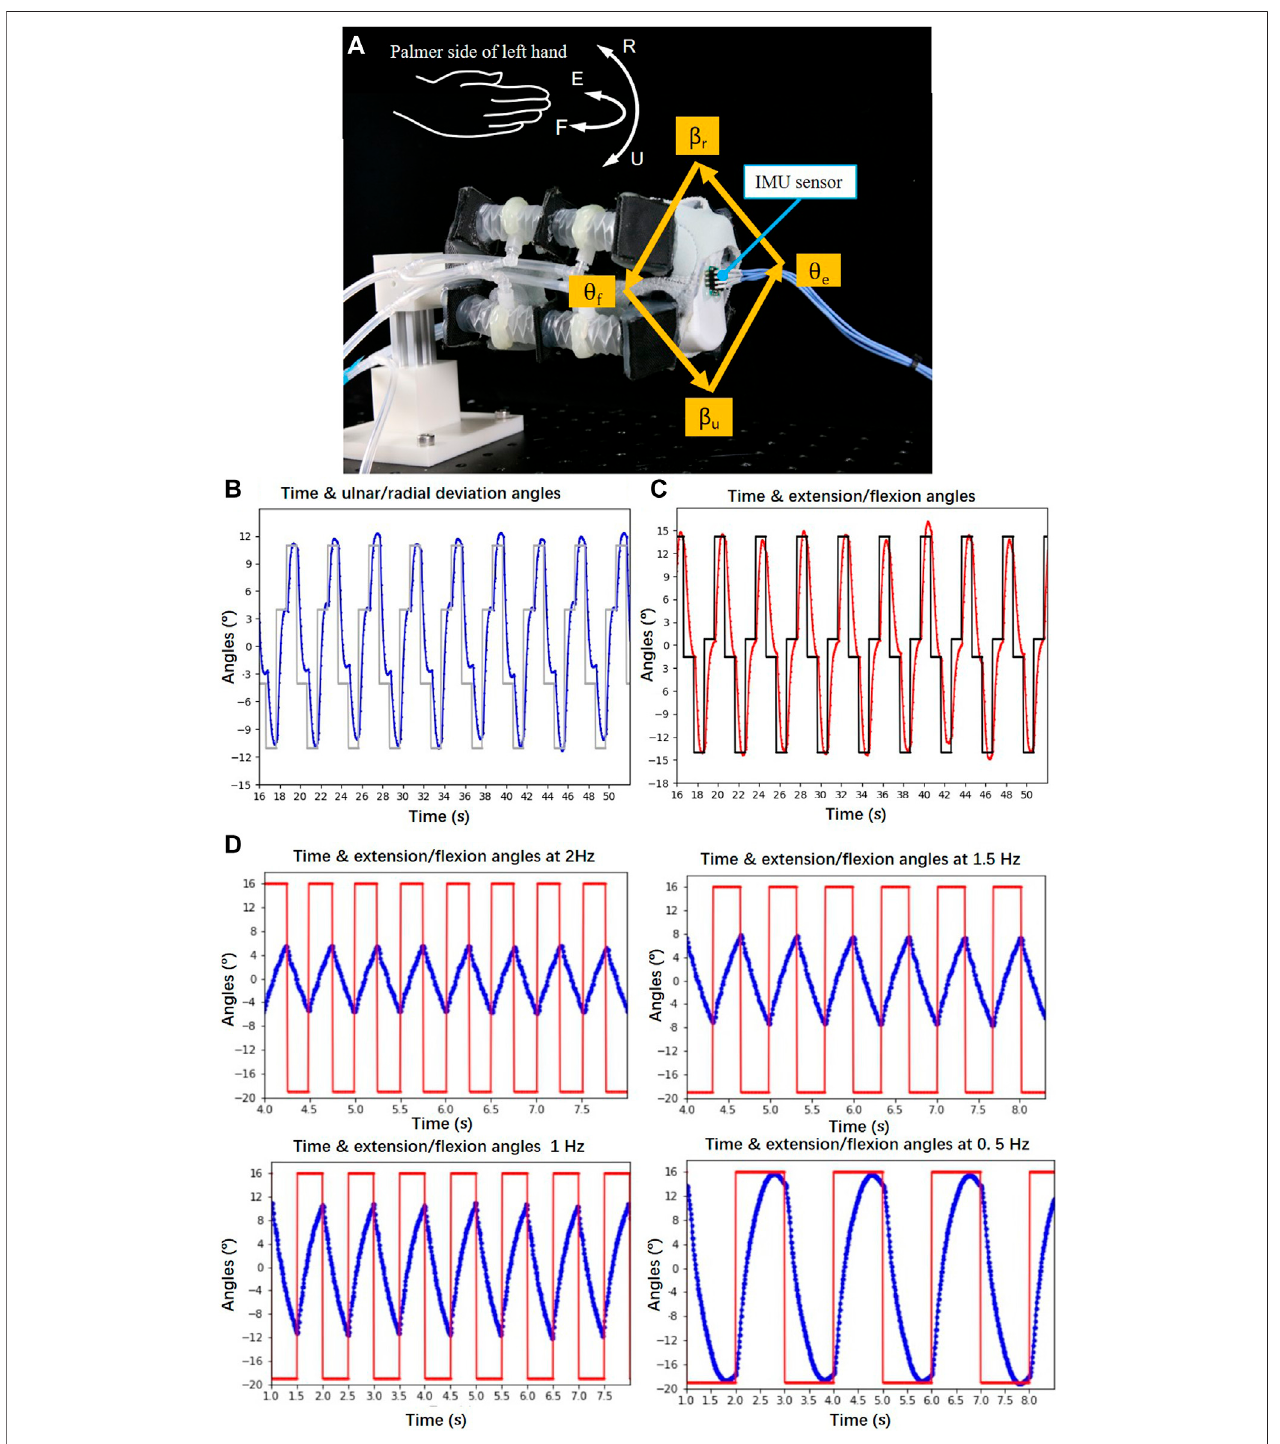
FIGURE 9 | The control performance was tested; (A) a IMU sensor was attached to the distal end of the test rig to measure the motion of the SR brace; a quadrilateral loop route was de fi ned for the end of the brace to follow; (B) the ulnar/radial deviation angles β u and β r have been plotted against time; (C) the extension/ fl exion angles θ θ e and f were plotted against time; (D) the bandwidth of the brace was studied.